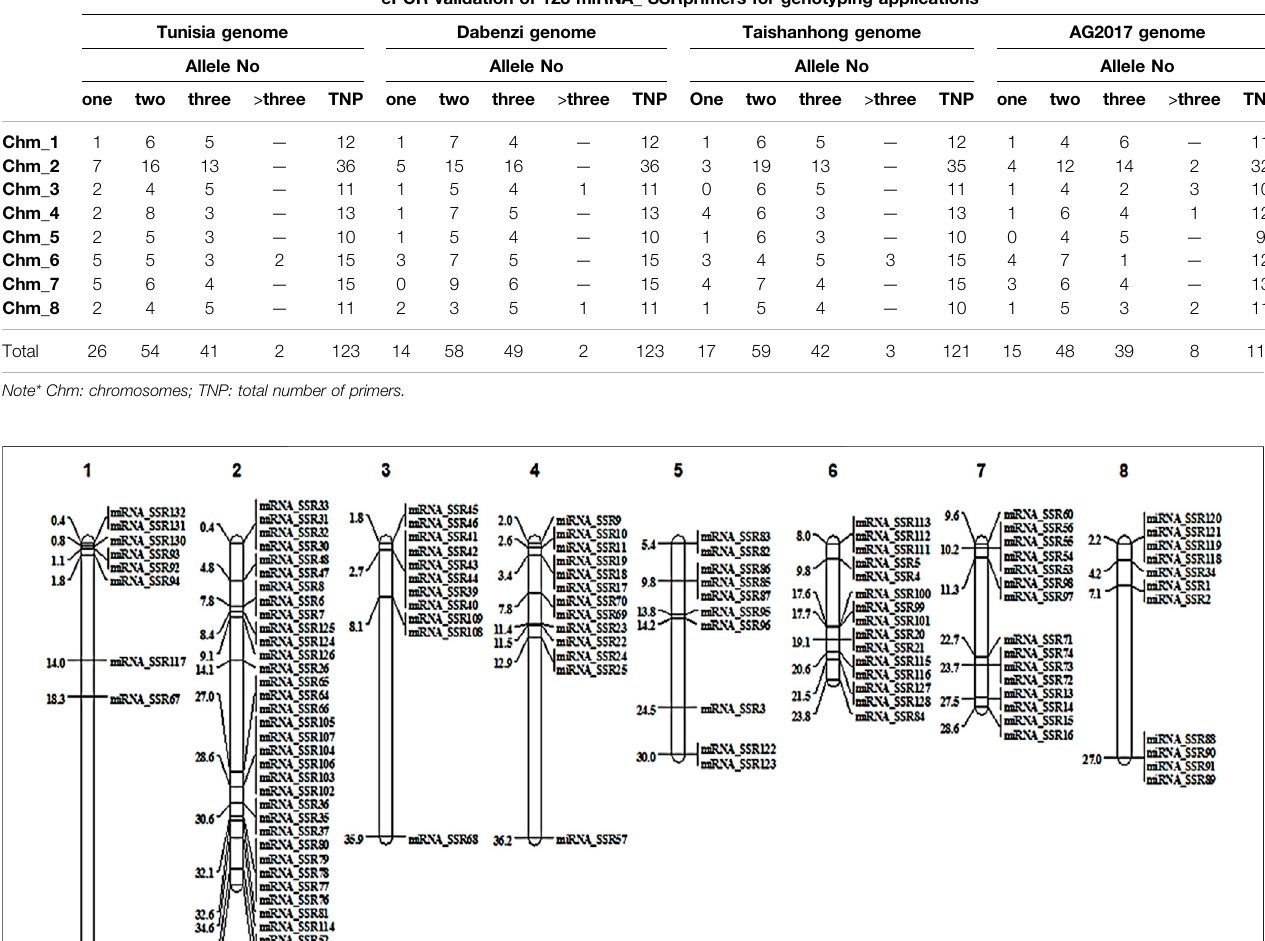
TABLE 2| Experimental validationof 123miRNA_SSRs in Tunisia genome in comparison toother three draft genomes ofpomegranate cultivars Dabenzi, Taishanhong and AG2017 through ePCR or eMapping. ePCR validation of 123 miRNA_ SSRprimers for genotyping applications Tunisia genome